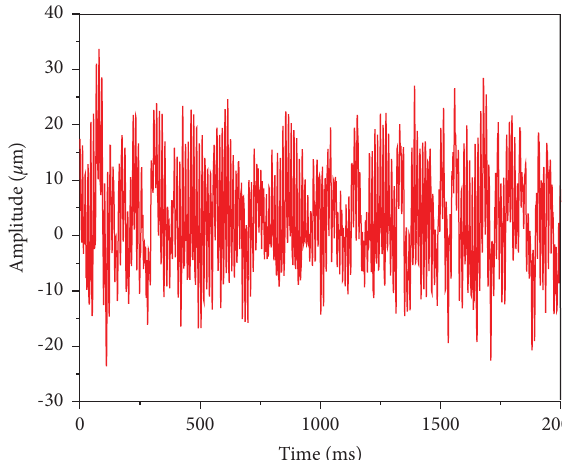
Figure 4: Vibration time domain diagram of core fault signal.